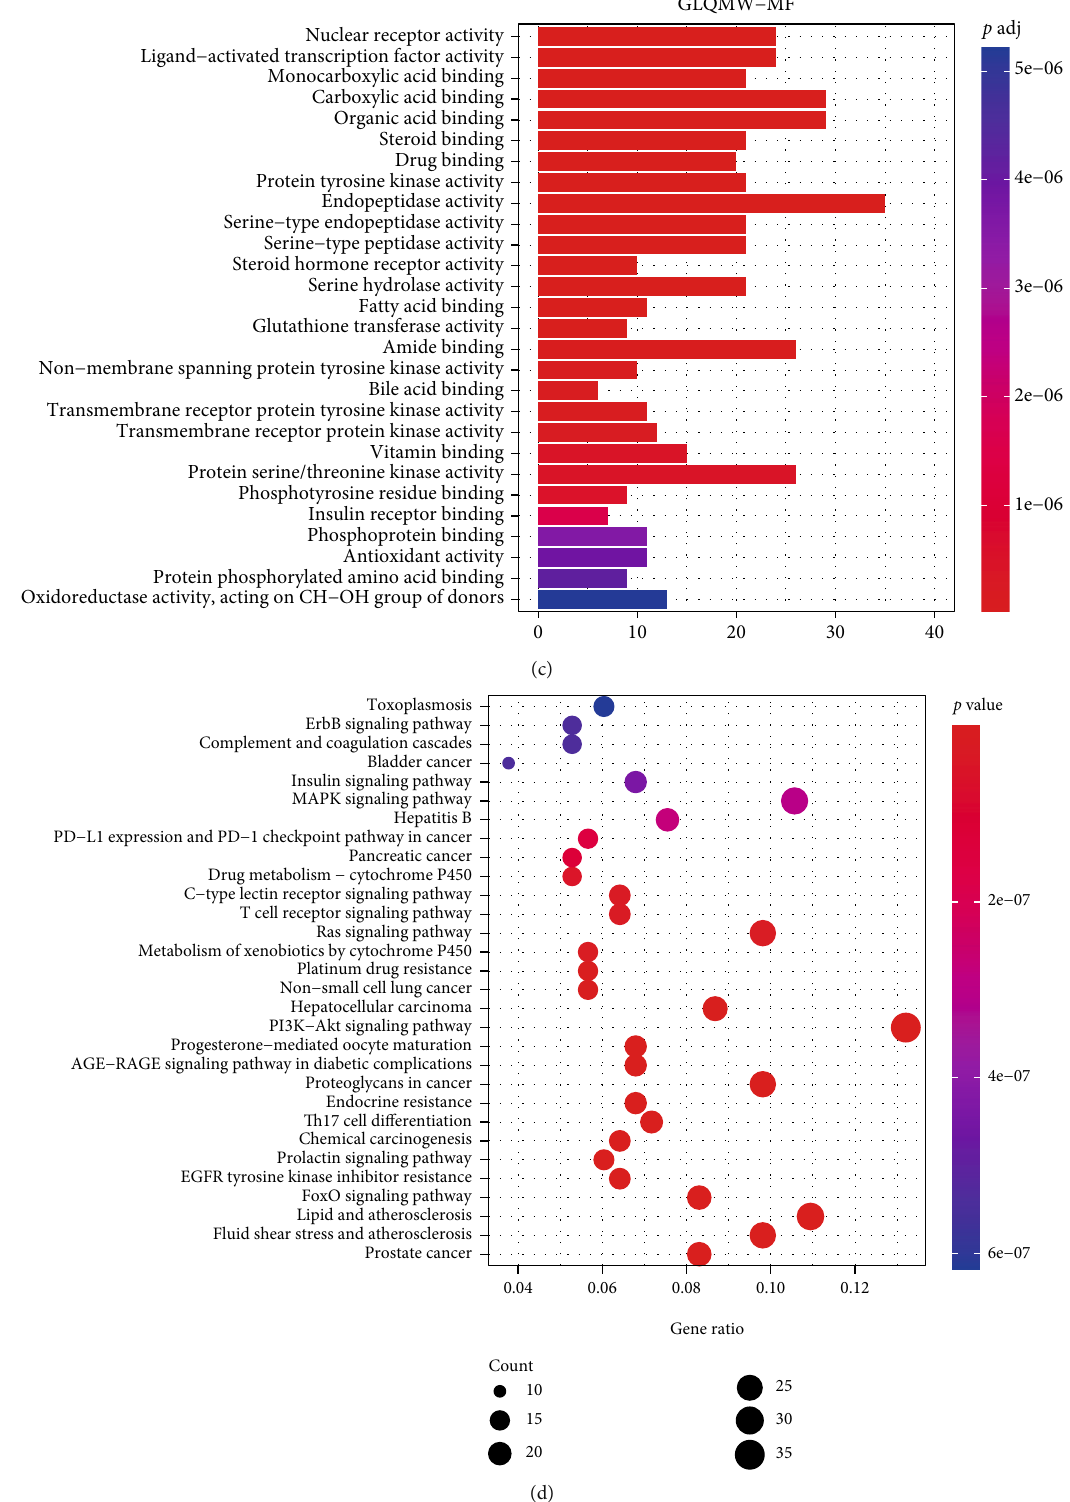
Figure 8: GO and KEGG analysis of the GLQMW target